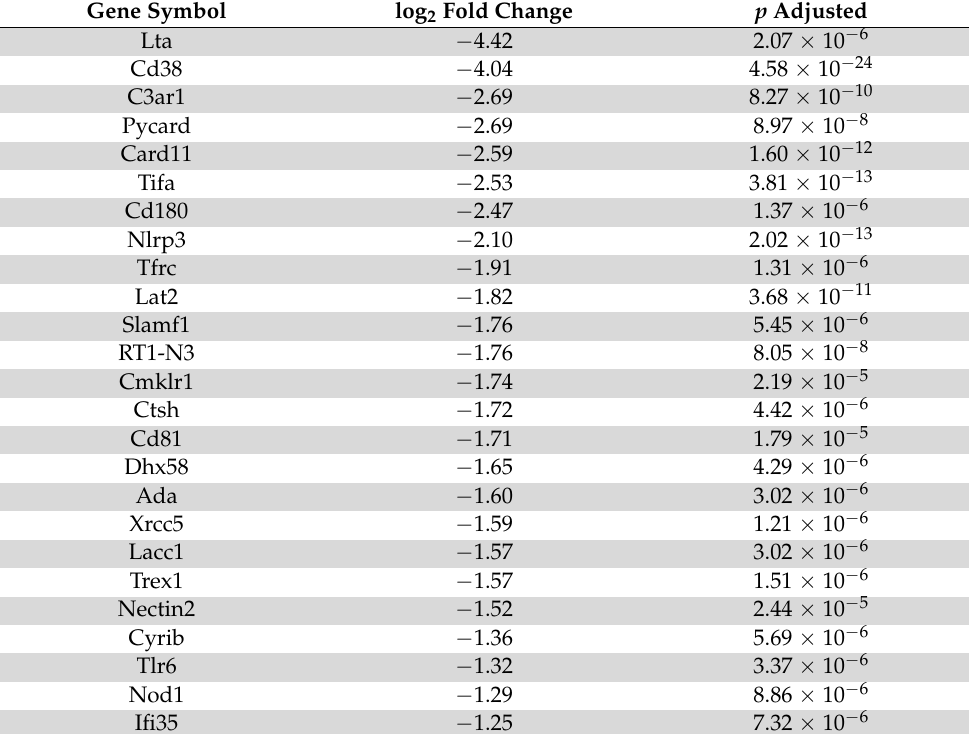
Table 1. Positive regulation of immune